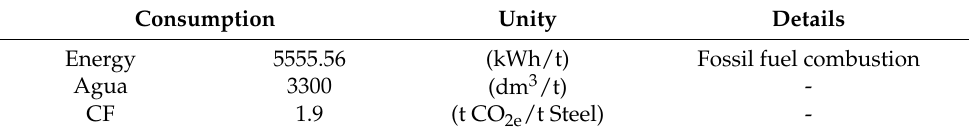
Table 16. Steel production energy and material consumption data [69].